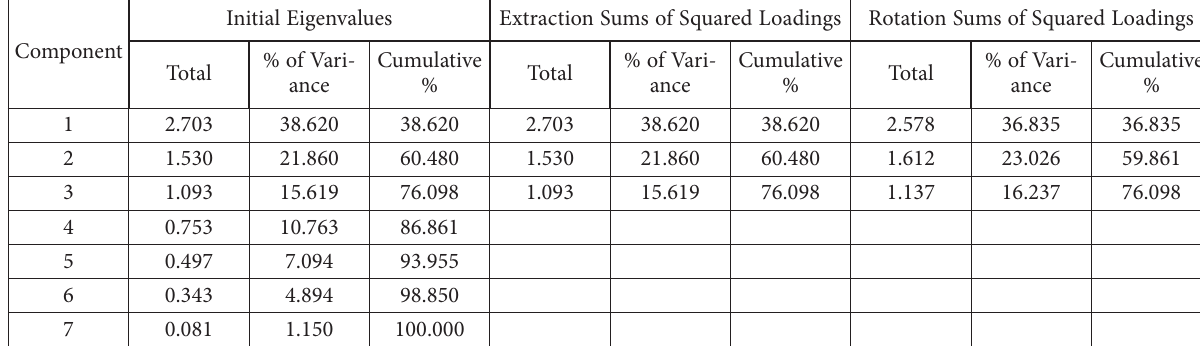
Table 7a. Total explained variance of the micro-nutrient data